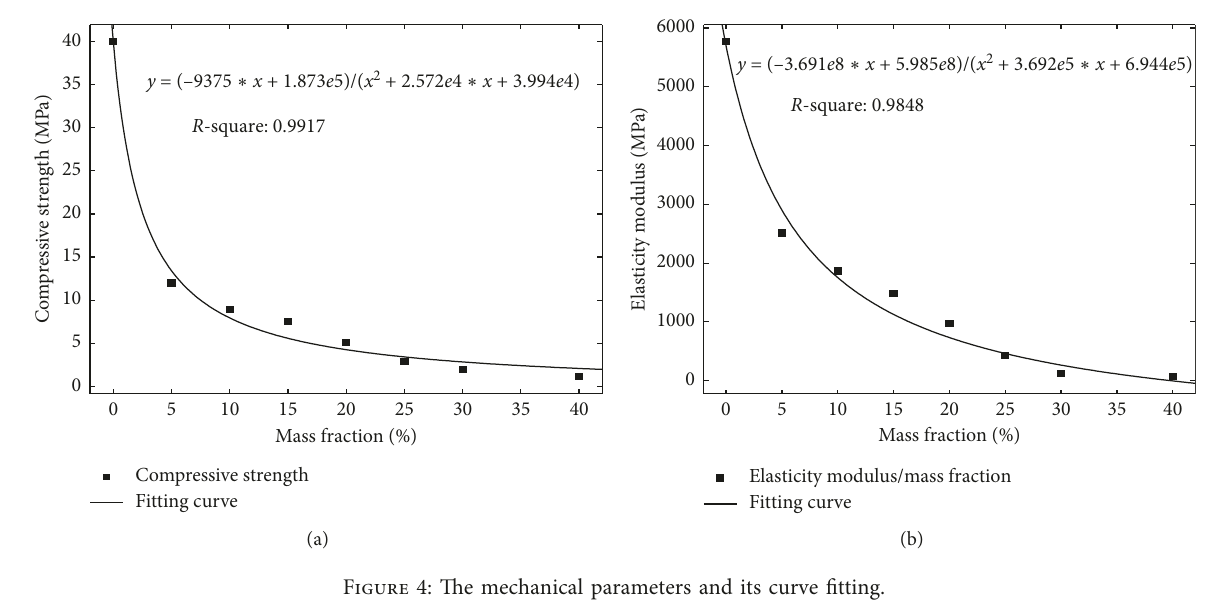
Figure 4: The mechanical parameters and its curve